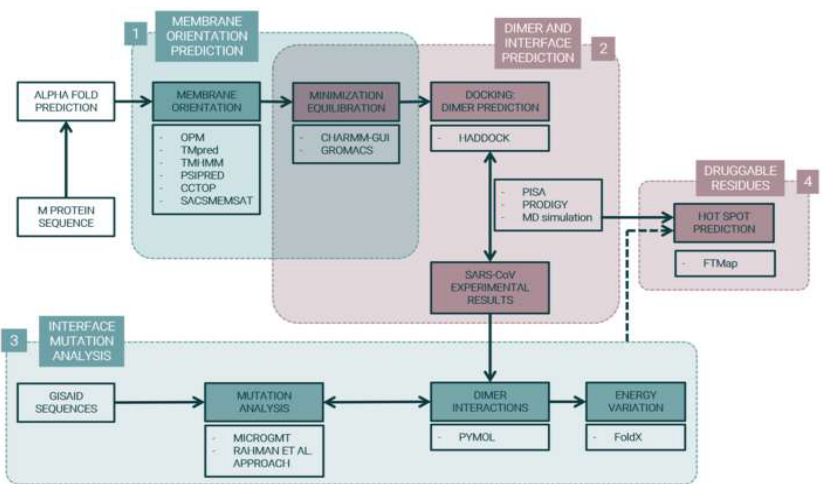
Figure 1. Project Pipeline. M protein structure was predicted by AlphaFold [31]. (1) Membrane orientation was predicted with Orientations of Proteins in Membranes (OPM) [32], prediction of Transmembrane Helices (TMpred) [33], TransMembrane prediction using cyclic Hidden Markov Model (TMHMM) [34,35], Prediction of secondary structure (PSIPRED) [36,37], Consensus Constrained TOPology prediction (CCTOP) [38,39], and Sequence Analysis and Consulting Service MEMbrane protein Structure And Topology (SACSMEMSAT) [40]. Protein–membrane systems were constructed with Chemistry at HARvard Macromolecular Mechanics Graphical User Inter- face (CHARMM-GUI) [41] and minimization and equilibration were conducted using GROningen MAchine for Chemical Simulations (GROMACS) [42,43]. (2) M protein dimer was predicted with High Ambiguity Driven protein–protein DOCKing (HADDOCK) [44] and results were compared to SARS-CoV experimental data. (3) Gene and protein mutations were analyzed with Microbial Genomics Mutation Tracker (MicroGMT) [45] and Rahman et al. [46] programs and energy variation of mutations in dimer interaction residues were calculated with FoldX [47]. (4) Druggable residues